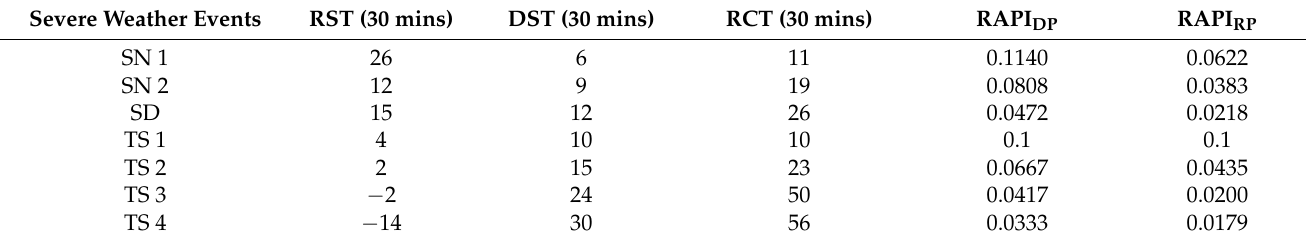
Table 3. Summary of calculation results under different severe weather conditions.